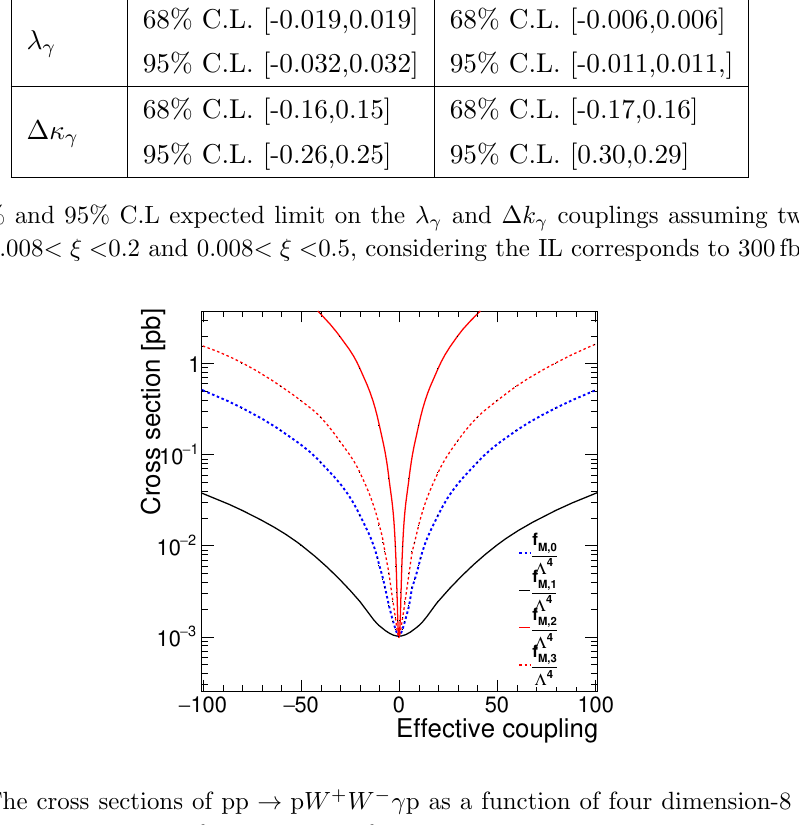
Figure 11 . The cross sections of pp ! p W + W (cid:0) (cid:13) p as a function of four dimension-8 anomalous QGCs at proton-proton center-of-mass energy of 13